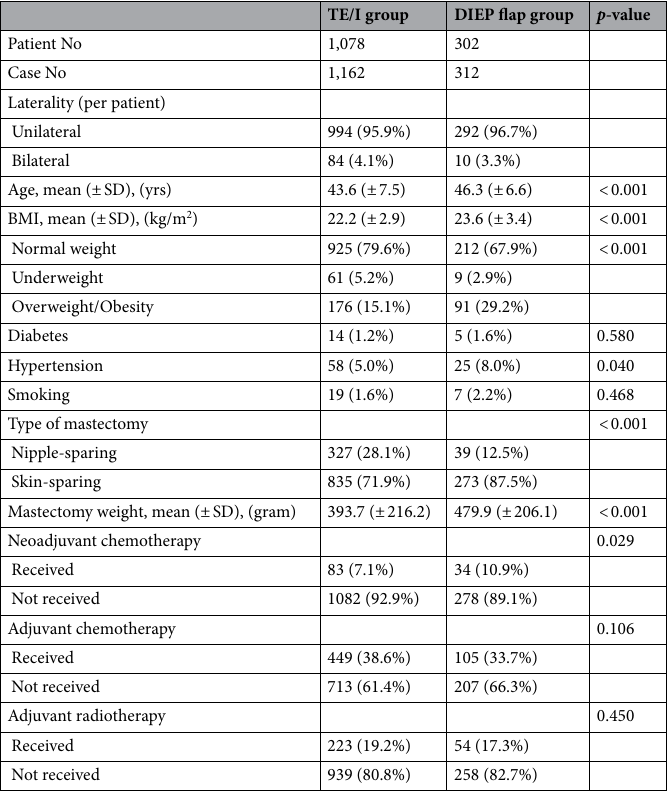
Table 1. Comparison of baseline characteristics between DIEP flap versus TE/I